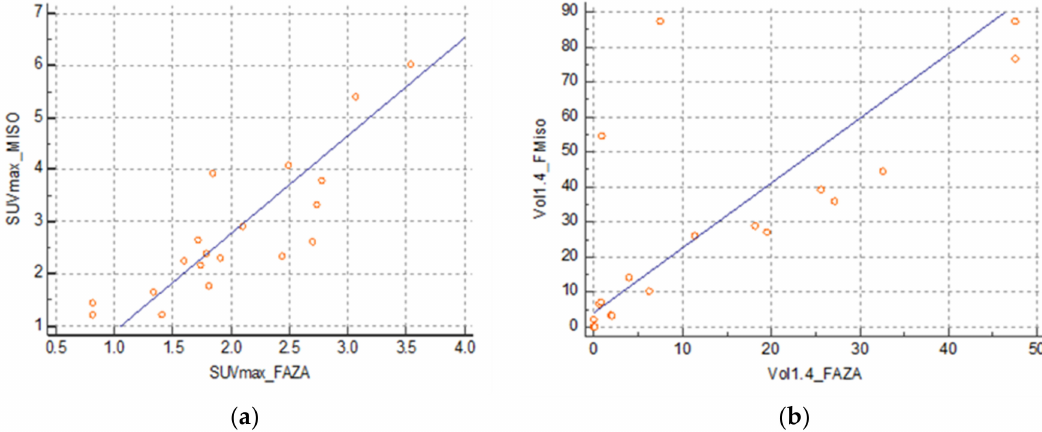
Figure 3. ( a ) Correlation between SUVmax FMISO and FAZA and ( b ) correlation between volumes FMISO and FAZA with a threshold of